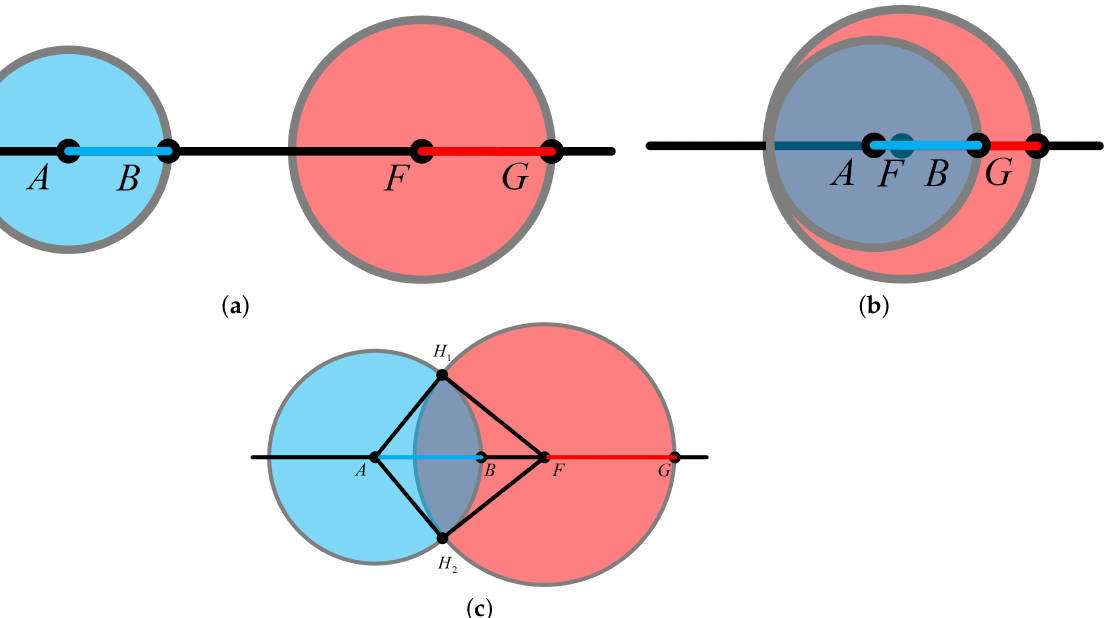
Figure 6. Three types of Earth-shadow. ( a ) Occlusion situation 1. ( b ) Occlusion situation 2. ( c ) Occlusion situation